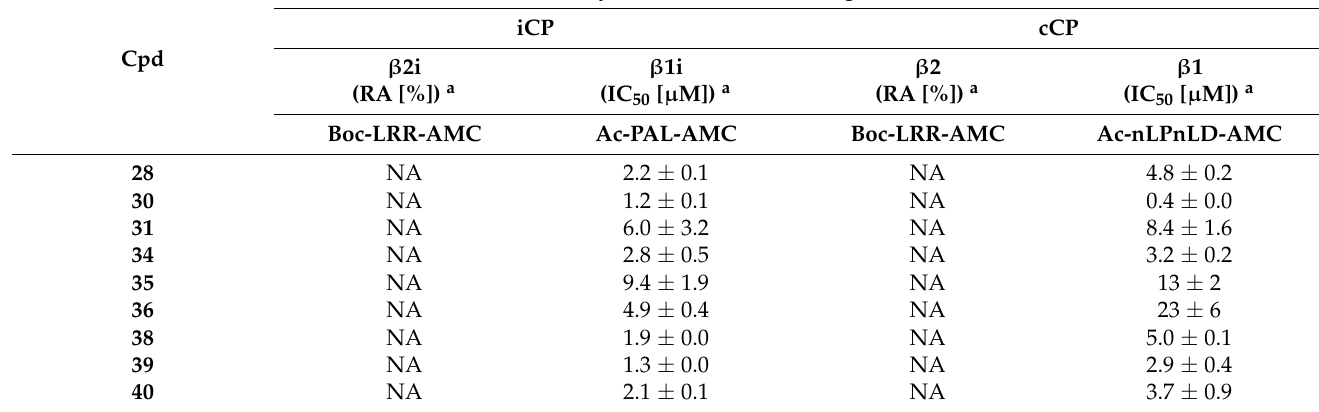
Table 6. Inhibitory potencies of selected bidentate compounds against β 2i and β 1i subunits of human iCP and against β 2 and β 1 subunits of the human cCP. The IC 50 values were determined for compounds that showed notable inhibition at 10 µ M (RA < 60%). For β 2i and β 2, we measured RAs in the presence of 10 µ M of each compound. The same control compound, i.e., bortezomib, was used as indicated in Table 3. Inhibitory activities of compounds against subunits β 1, β i, β 2, and β 2i were measured using PA28 α as the proteasome